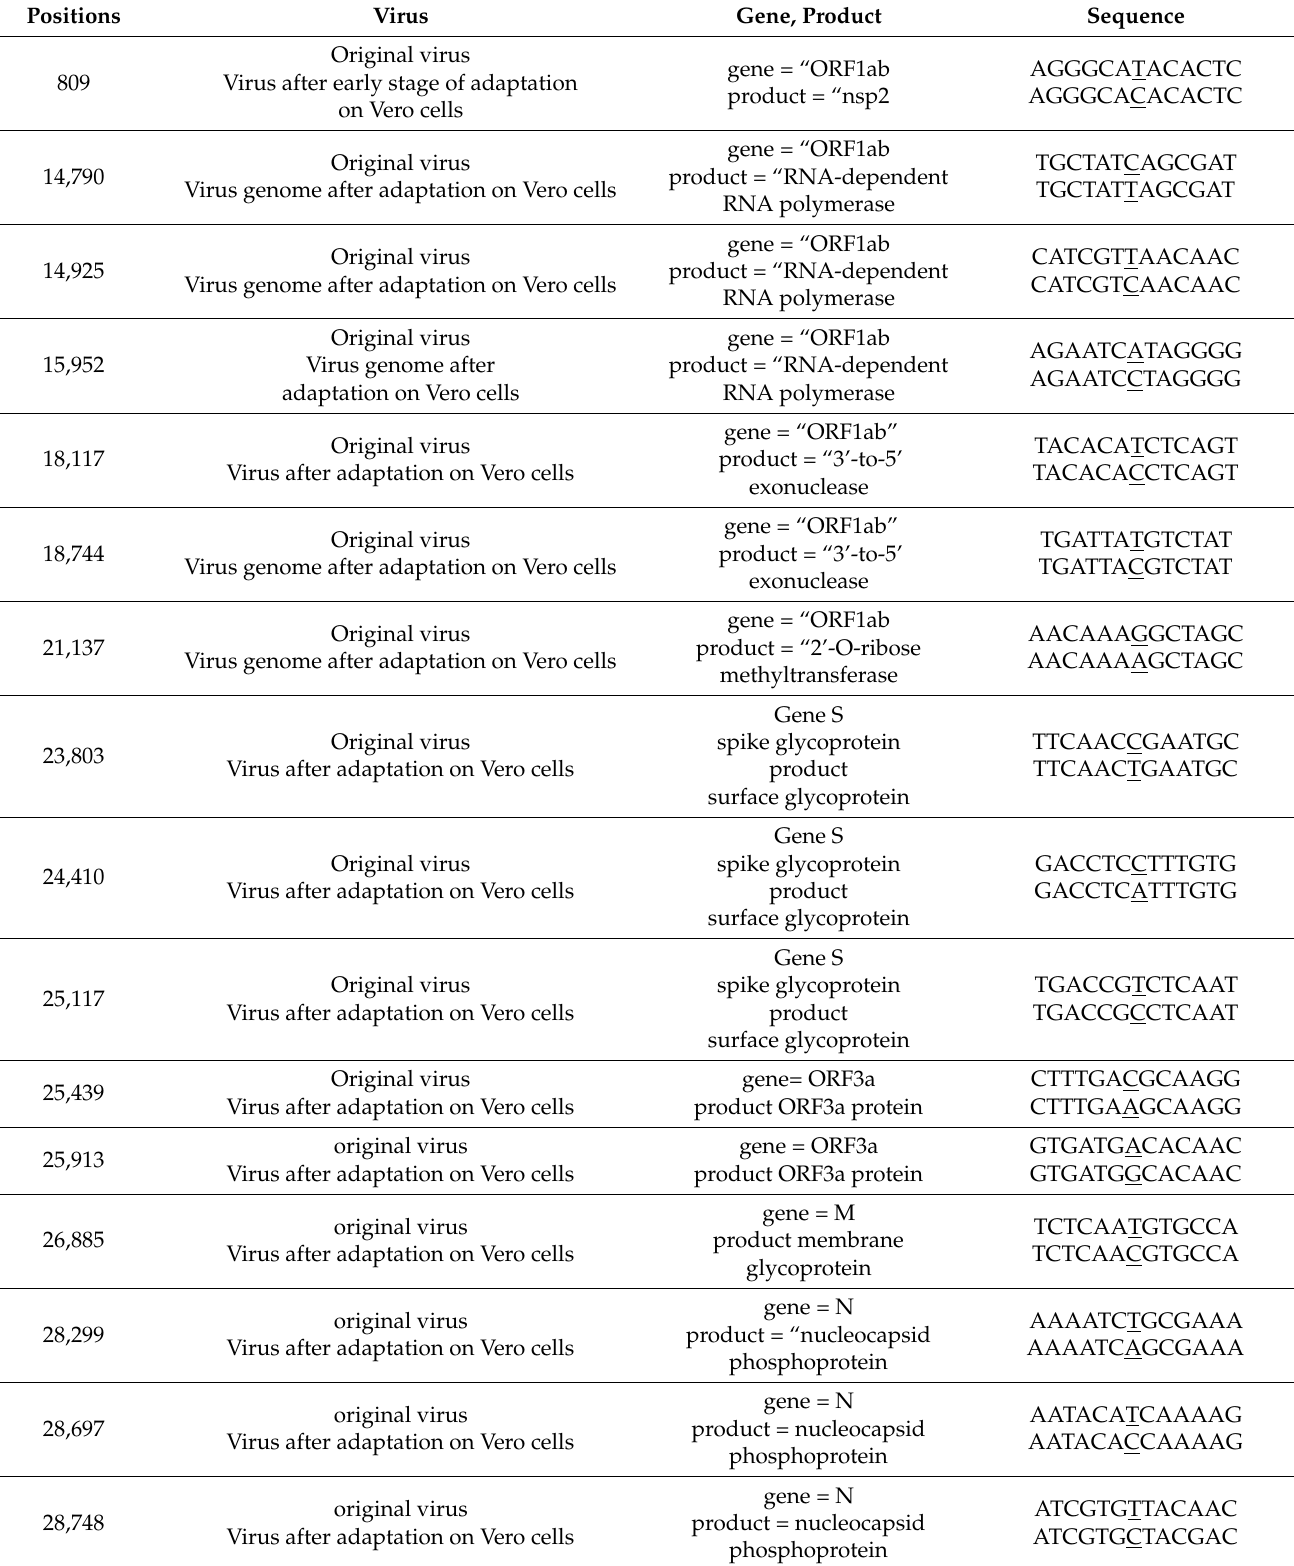
Table 1. The SNPs in genes obtained by sequencing the SARS-CoV-2 virus adapted on Vero cells.